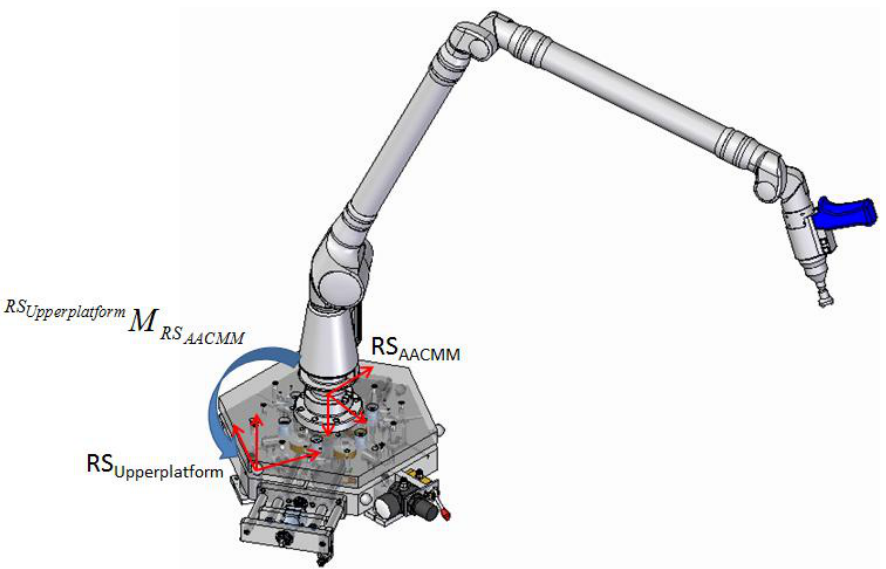
Figure 21. Reference systems of the AACMM and upper